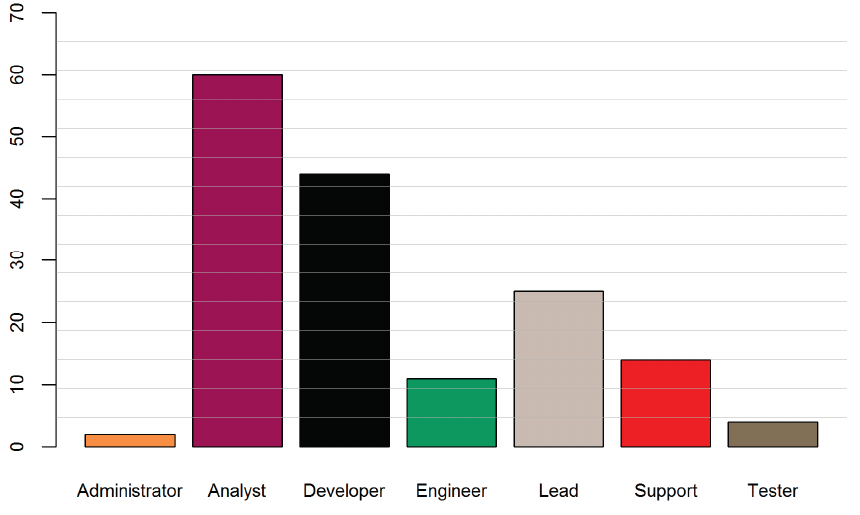
Figure 12. Predictions for Specialist vacancies (unseen